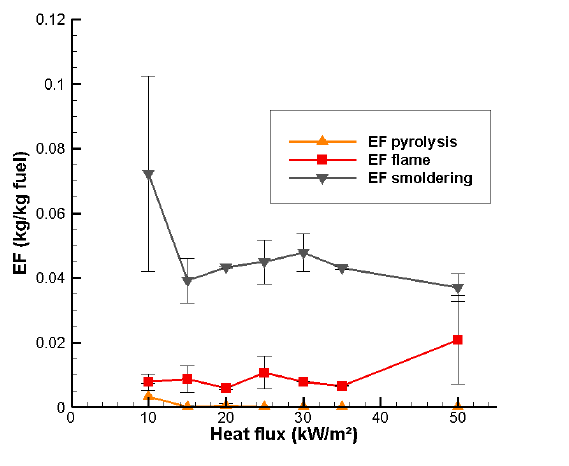
Figure 12. EF for CO 2 for an imposed heat fl ux ranging from 10 to 50 kW/m 2 for ( a ) wood and ( b ) thermoplastic samples.